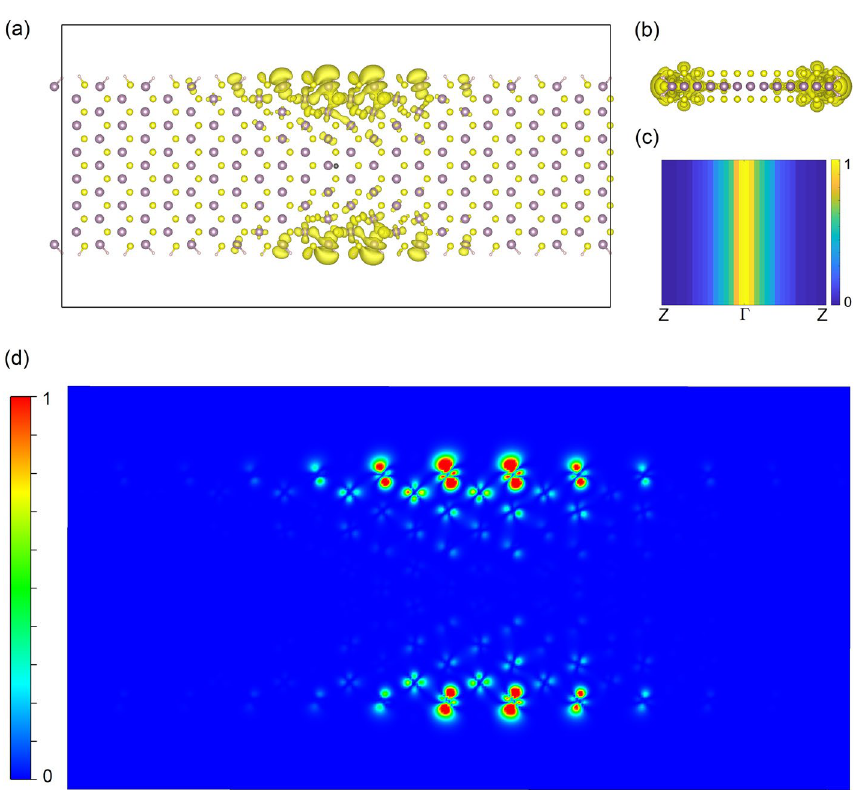
Figure 6. The exciton state forming peak A ′ (Fig. 5a) in real space ( a ) top view, ( b ) side view, and in k space ( c ). The hole (black spot in ( a )) is located at the center of the ribbon and near a Mo atom. The isosurface contour of the modulus squared exciton wavefunction is shown in ( a ) and ( b ). The profile (arbitrary unit) of the modulus squared exciton wavefunction in k space is shown in ( c ), showing it is around the Ŵ point, and in real space is shown in ( d ), showing the electron in the exciton is mainly located on the edge Mo atoms. The plots for other exciton states are in Figs. S11–S20 (Supporting